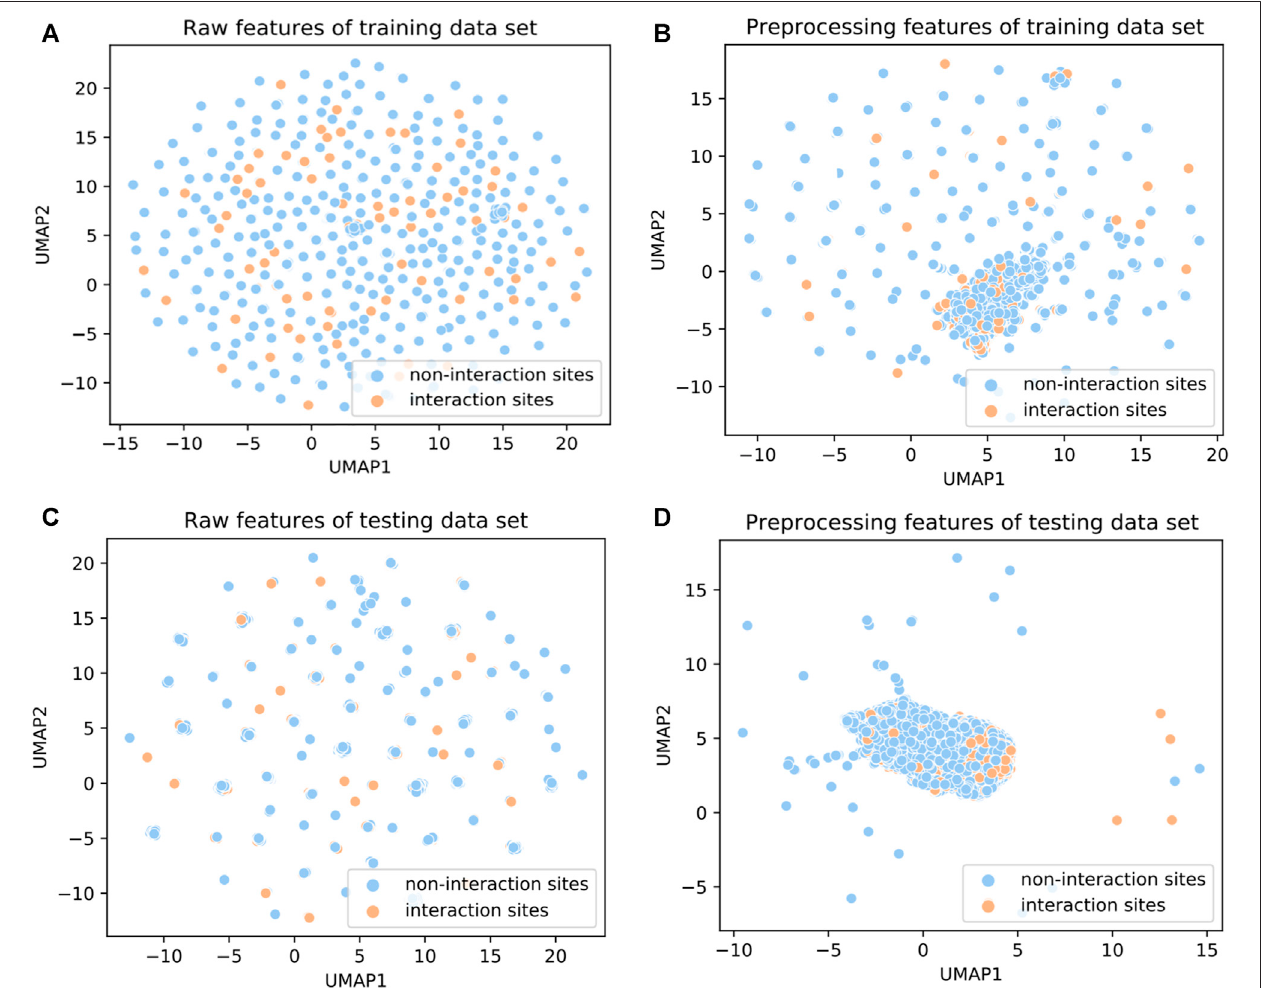
FIGURE 2 | UMAP diagrams of (A) raw features of the training set, (B) preprocessing features of the training set, (C) raw features of the testing set, and (D) preprocessing feature of the testing set.